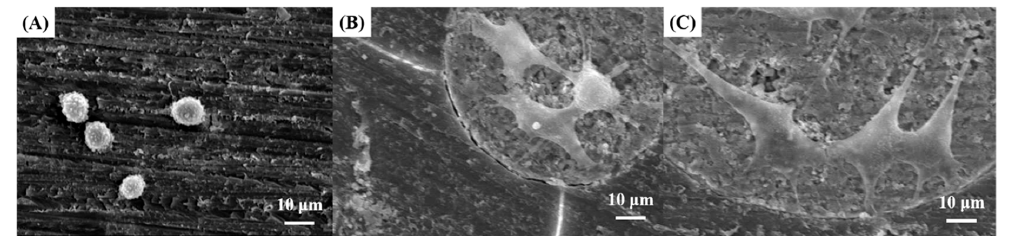
Figure 7. Representative SEM images of the MC3T3-E1 on ( A ) PMMA with barium sulfate as an additive; PMMA/HA composites with various HA contents of ( B ) 20 vol % and ( C ) 40 vol % after 6 h of culturing.